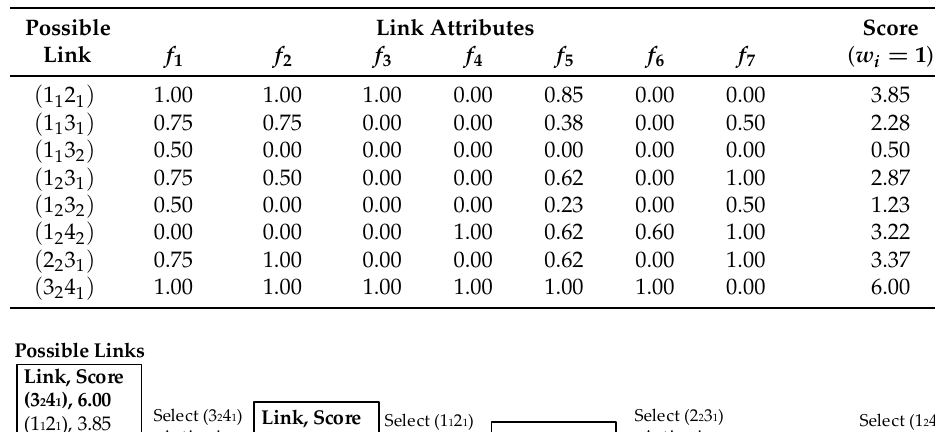
Table 3. List of possible links and their associated attributes and scores.